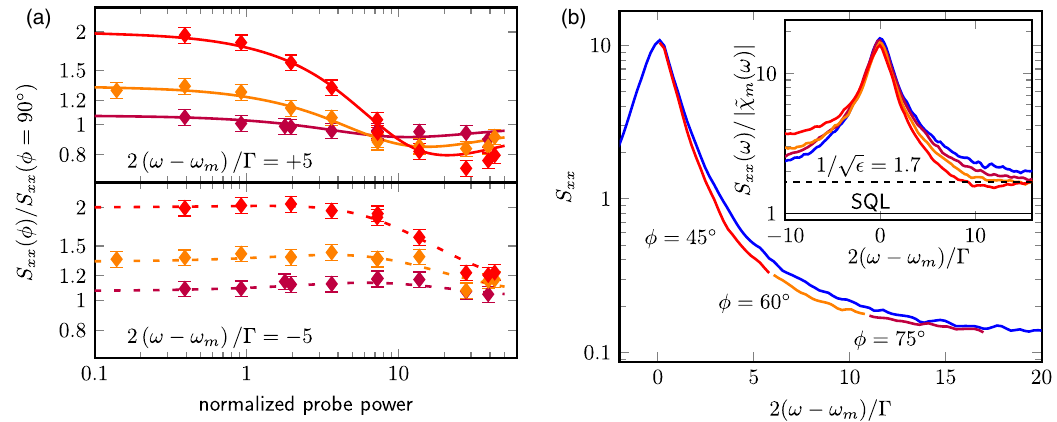
FIG. 3. Components of variational readout. (a) Ratio of PSD in quadratures ϕ ¼ 45 ° (red), ϕ ¼ 60 ° (orange), and ϕ ¼ 75 ° (purple) to that in ϕ ¼ 90 ° as a function of normalized probe power p . The top panel is at a detuning of 2 ð ω − ω 2 ð ω − ω = Γ ¼ − 5 . (b) Reconstruction of variational readout for p ¼ 14 . The measured quadratures [same colors as (a)] are placed in m Þ the portion of the spectrum for which they provide the lowest imprecision. The result for ϕ ¼ 90 ° (blue) is shown for comparison. Inset: Measured quadratures [same colors as (b)] at p ¼ 28 normalized to the corresponding SQL at each